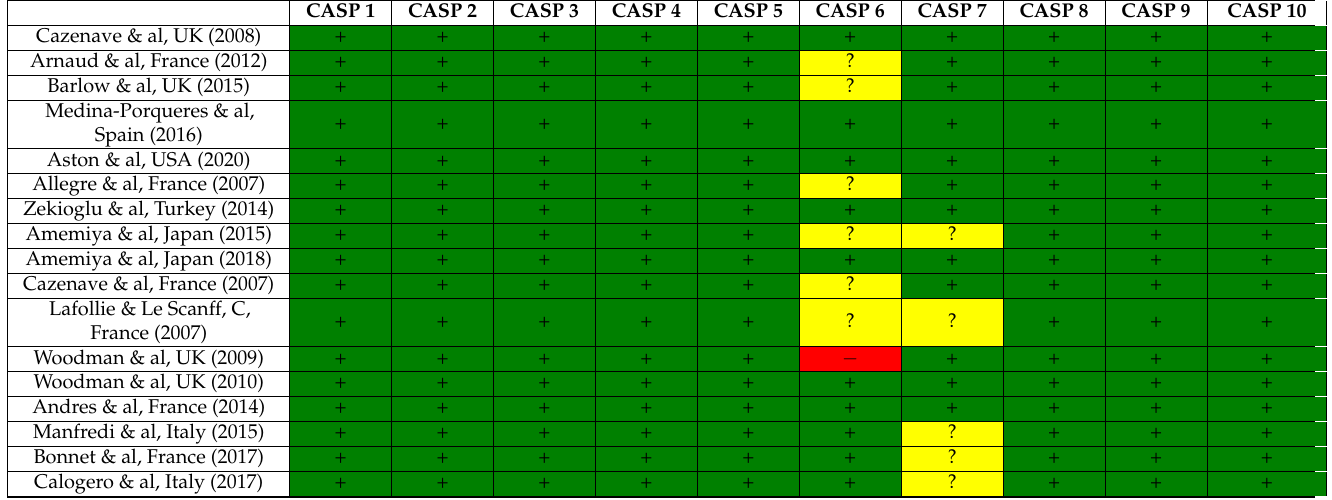
Table A1. The methodological quality of the included studies assessed by the